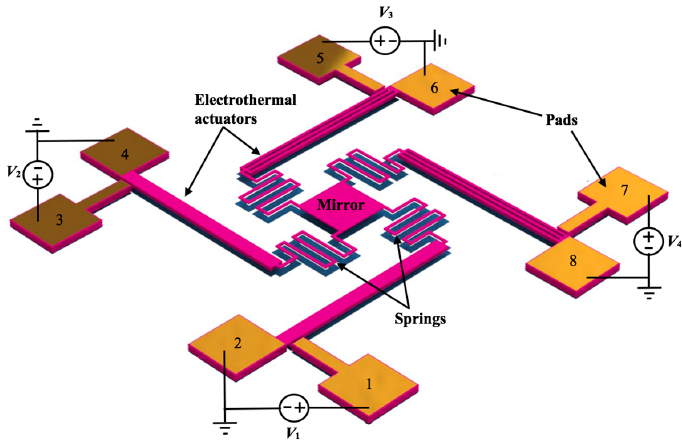
Figure 1. Design of an electrothermal actuation mechanism for the rotation of a microelectromechanical systems (MEMS) mirror.